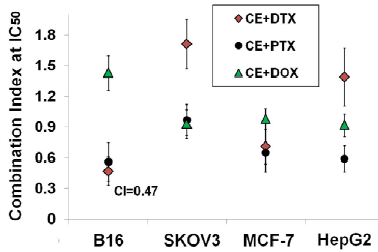
Figure 2. Combination index (CI) values of CE + DTX, CE + PTX, and CE + DOX at 50% growth inhibition point on B16, SKOV3, MCF-7, and HepG2 cells ( n = 3) .